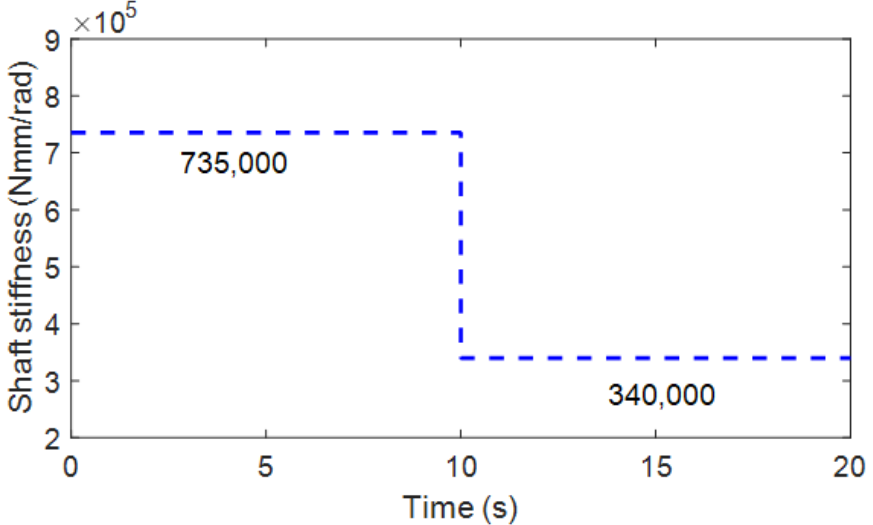
Figure 4. Crack scenario for sudden shaft torsional stiffness drop (735,000 → 340,000 Nmm/rad). The initial state value and error covariance for estimation are as follows: